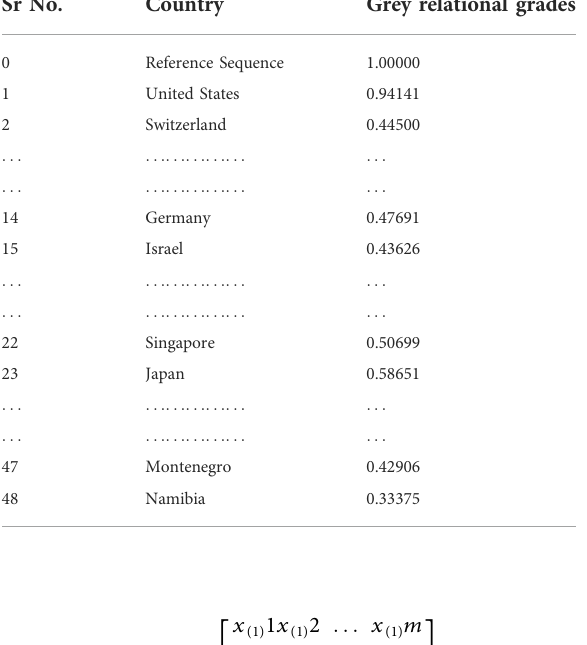
TABLE 7 Grey relational grades. Sr No. Grey relational